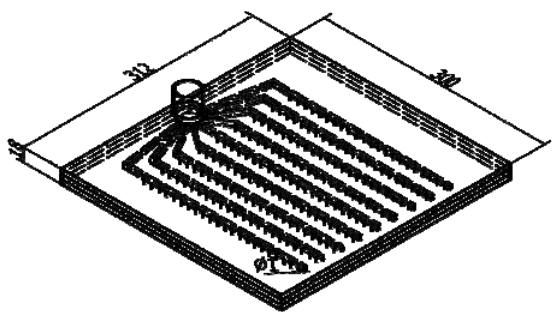
Fig. 1. Droplet generator with the 1 mm holes .